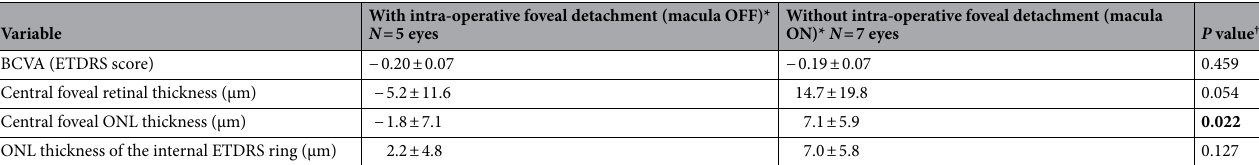
Table 4. Analysis of changes stratified according to intra-operative foveal detachment. BCVA best-corrected visual acuity, ETDRS early treatment diabetic retinopathy study, ONL outer nuclear layer. *Data reported as mean ± standard deviation. † p -values are obtained by generalized estimating equation regression models; statistically significant p -values are shown in